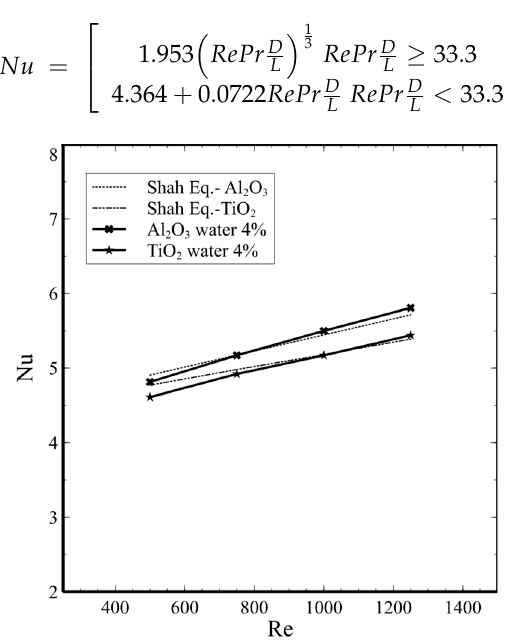
Figure 12. Comparison of Nu with literature: Al 2 O 3 -water nanofluid at φ b = 4%.